Question: Write the caption for this figure.
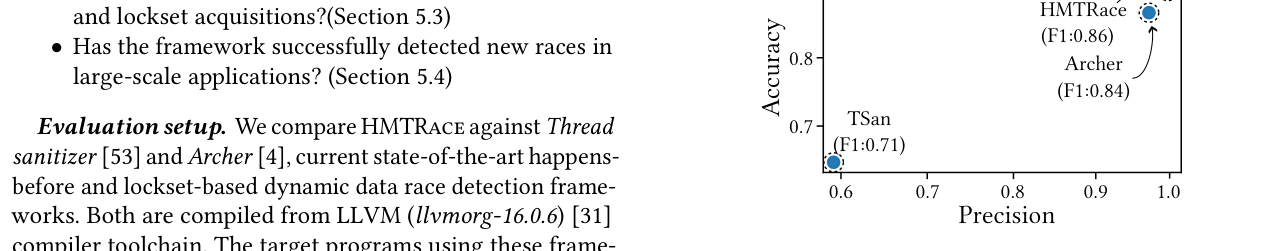
Answer: Precision and accuracy of the dynamic race detec- tion tools. The F1-score, representing the weighted average of precision and accuracy, is listed within parentheses.